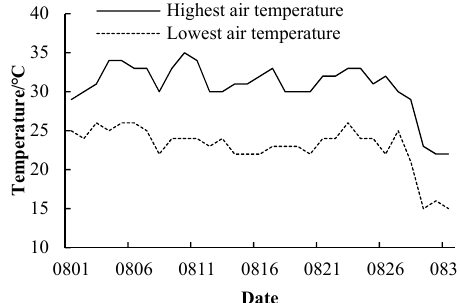
Figure 1. Daily maximum and minimum temperature in August in 2017.